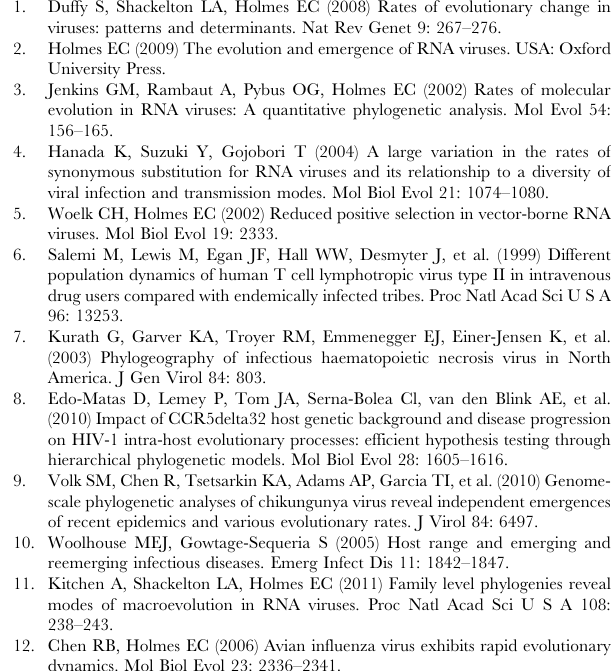
Table S2 Ecological traits of bat species and data sources. Mass independent values of basal metabolic rate (BMR) and torpid metabolic rate (TMR) were used. Rates that were calculated using data on body mass and metabolic rates (see Materials and Methods) are indicated by ‘‘a’’. Climatic regions abbreviated as follows: TR = tropical; ST= subtropical; TE = temperate. Repre- sentative species trait values are reported for viruses that circulate in several species of Myotis in the western United States. Table S3 Phylogenetic signal of bat and virus traits in the bat phylogeny as measured by Blomberg’s K and Pagel’s l . Values of Blomberg’s K were estimated for continuous traits with significance tested by 5000 randomizations of trait values on the phylogenetic tree of bats from COI sequences (Figure S1). Maximum likelihood (ML) values of l were estimated using the Geiger package of R with significance determined by likelihood ratio tests comparing models assuming the ML estimate of l to models assuming no phylogenetic signal ( l = 0) with 1 degree of freedom. When only two categories of climatic zone were included (tropical and subtropical versus temperate) the ML value of l was 1; however, this estimate was only marginally significantly better than the model assuming l = 0 ( P = 0.06). Table S4 The confidence set of generalized linear models examined to explain viral evolutionary rate. All models included a significant intercept term and had full model P values , 0.0001.